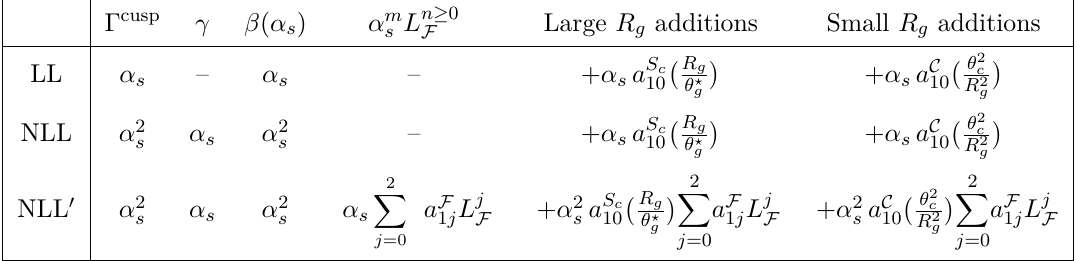
Table 1 . Highest order of the anomalous dimensions and fixed order terms that are needed for the given accuracy. The last two columns indicate additional fixed order terms that are added in the large R g and small R g regime